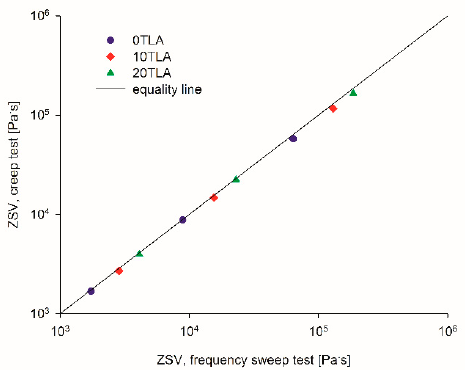
Figure 15. ZSV from creep test versus ZSV from the Cross model.